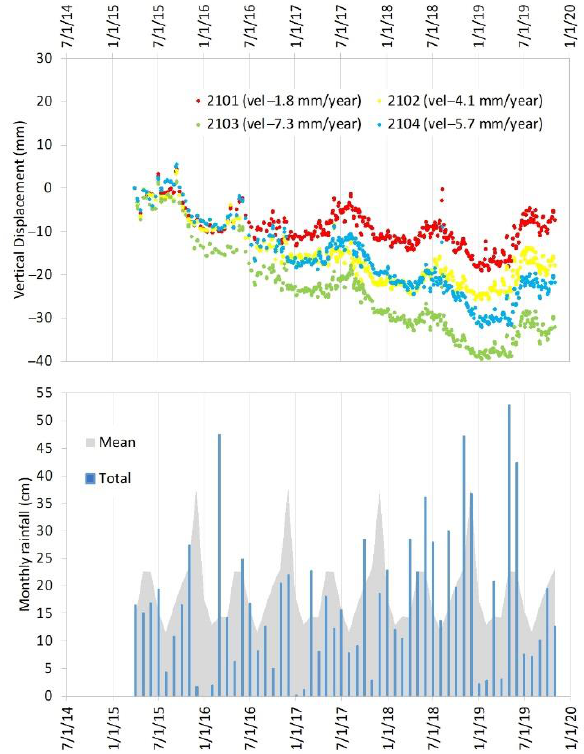
Figure 8. Comparison between vertical displacements estimated in the area of Rovegliana Church (Figure 7h) and monthly rainfall (blue bars). In grey, mean monthly rainfall calculated over the period 1994–2019 is shown.